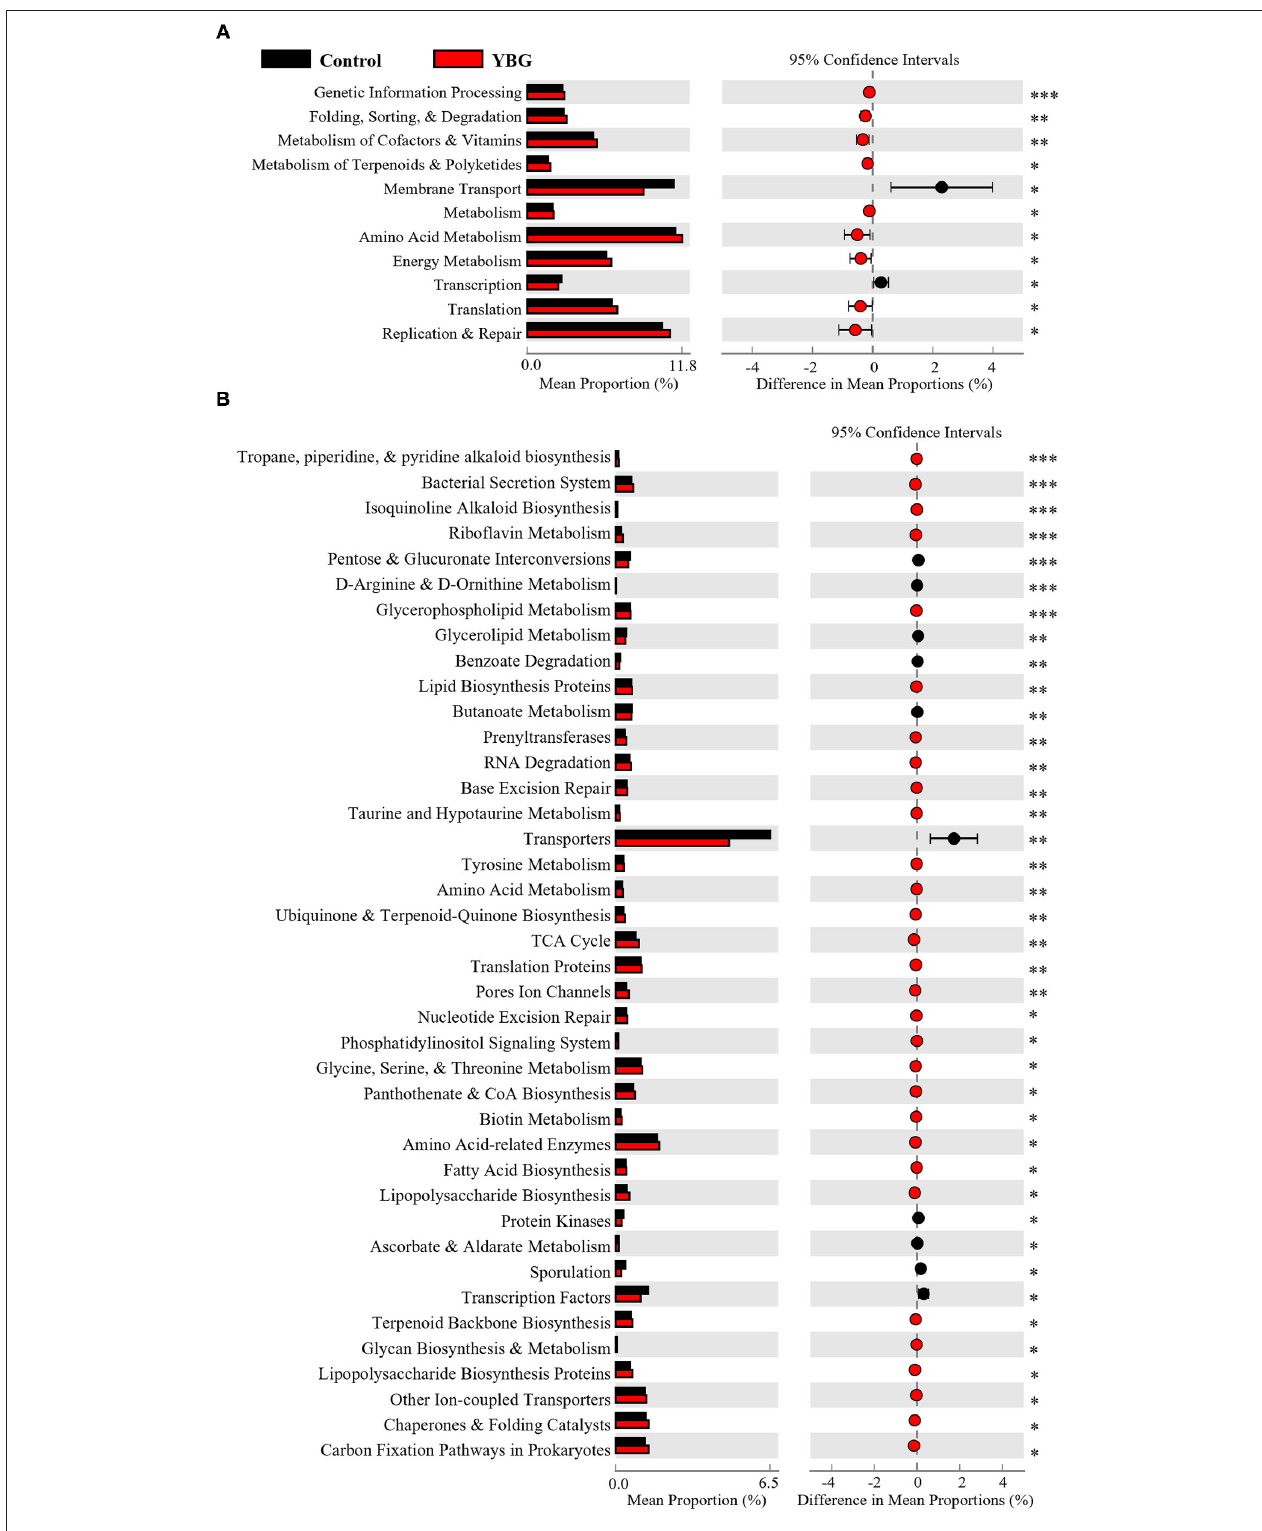
FIGURE 3 | Predicted functions of fecal microbiota of NOD mice treated with YBG for 30 days. PICRUSt was used to predict level 2 (A) and level 3 (B) functional profiles, based on the 16S rRNA gene sequence, of the fecal microbiota of YBG treated and control groups of mice. STAMP was used to analyze and visualize significantly altered functions between control and YBG-treated mice after 30 consecutive days of treatment. No significant differences were observed after in mice that were treated only for 7 days (not shown). FDR corrected p -values are shown. * p < 0.05, ** p < 0.01, *** p < 0.001.